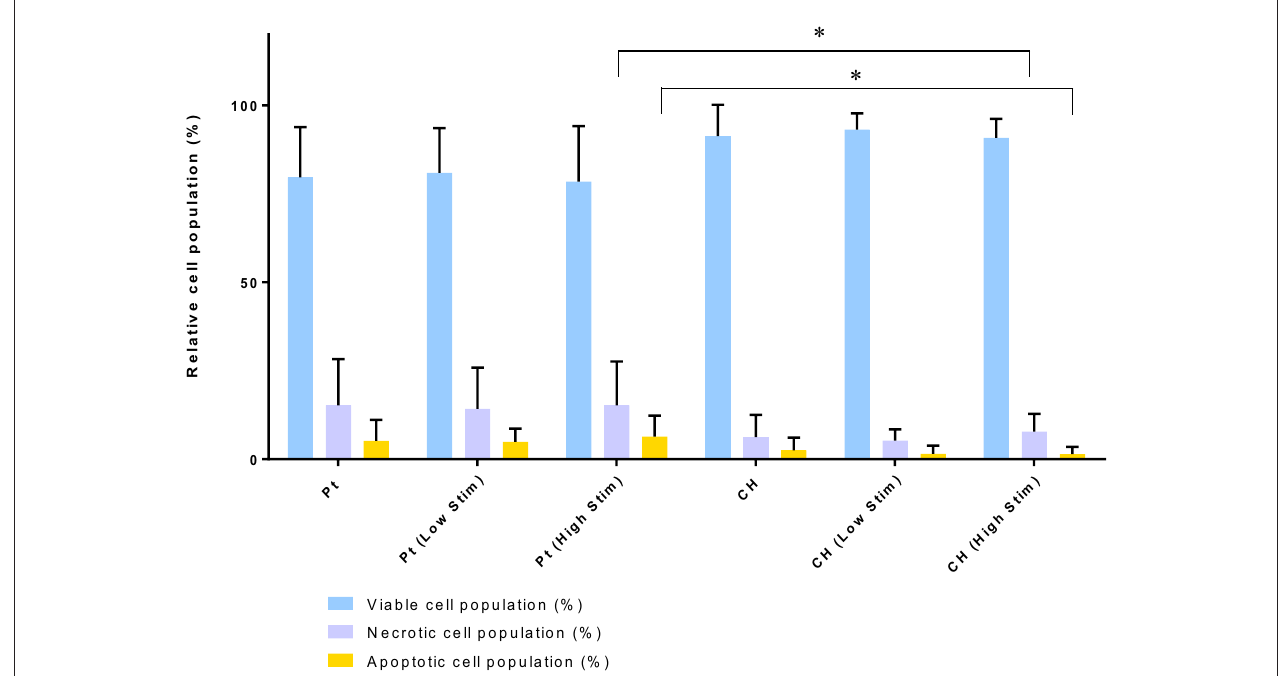
FIGURE 5 | Relative viable, necrotic, and apoptotic cell populations. Error bars represent standard deviation. (Tukey, Two-way ANOVA multiple comparisons test, * p < 0.05, n = 3).